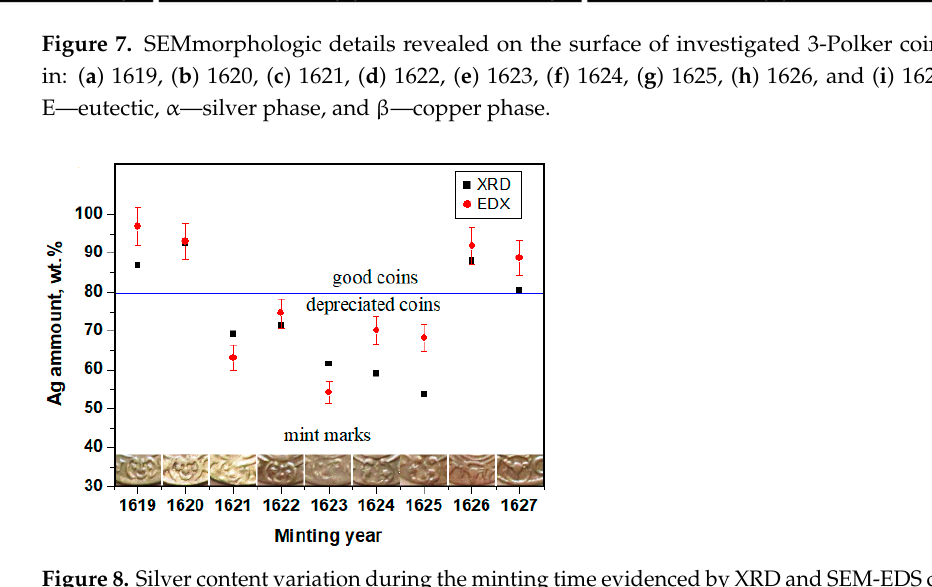
Figure 8. Silver content variation during the minting time evidenced by XRD and SEM-EDS com- pared with the aspect of the mint marks.